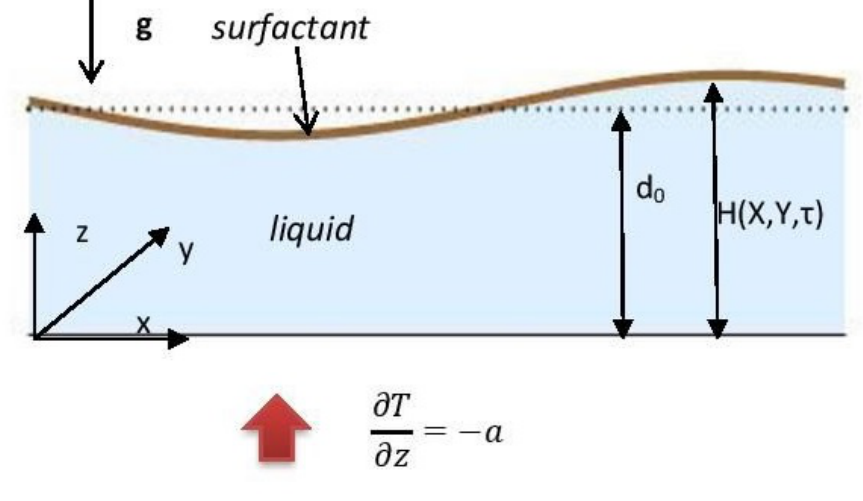
Figure 1. Schematic of the